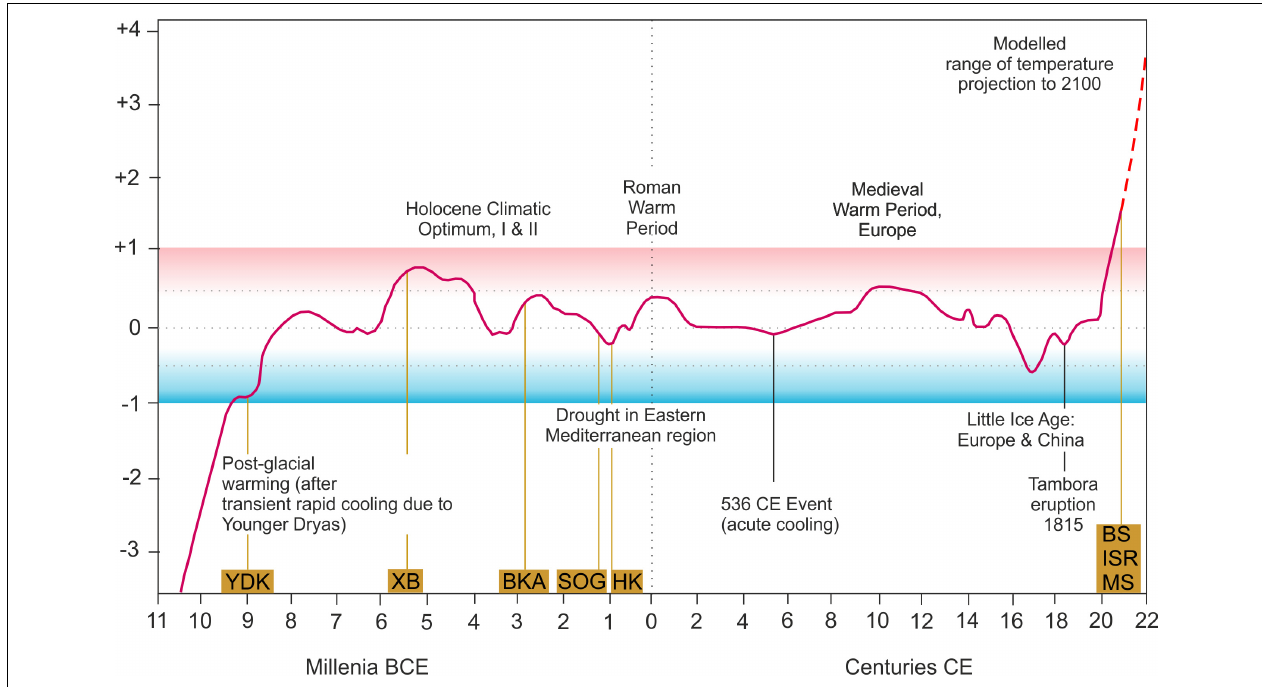
FIGURE 7 | Temporal distribution of the samples in relation to northern hemisphere temperature fluctuations during the Holocene, ◦ C (relative to mean temperature during 1960–1980), averaged from multiple sources [modified after McMichael (2012)].